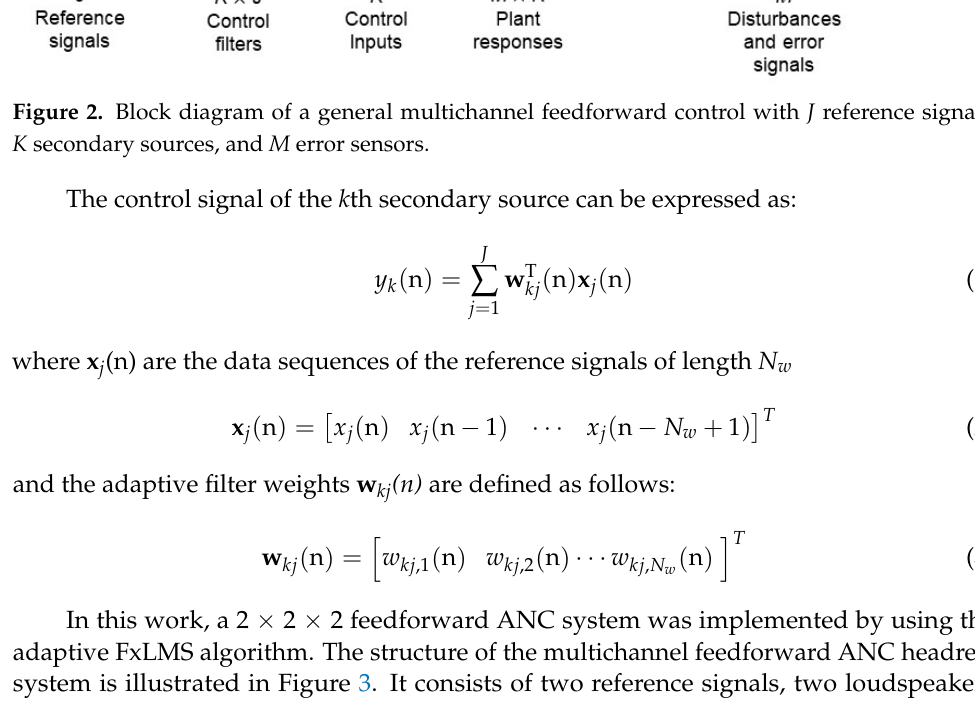
Figure 3. The block diagram of the 2 × 2 × 2 FxLMS algorithm for active noise cancellation of the ANC headrest system.